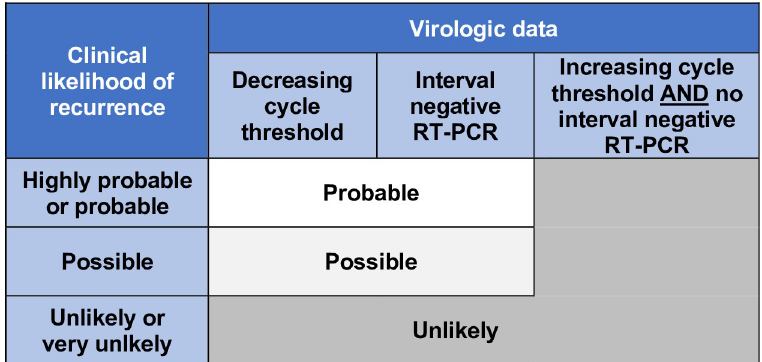
Fig 2. Algorithm for determining overall likelihood of COVID-19